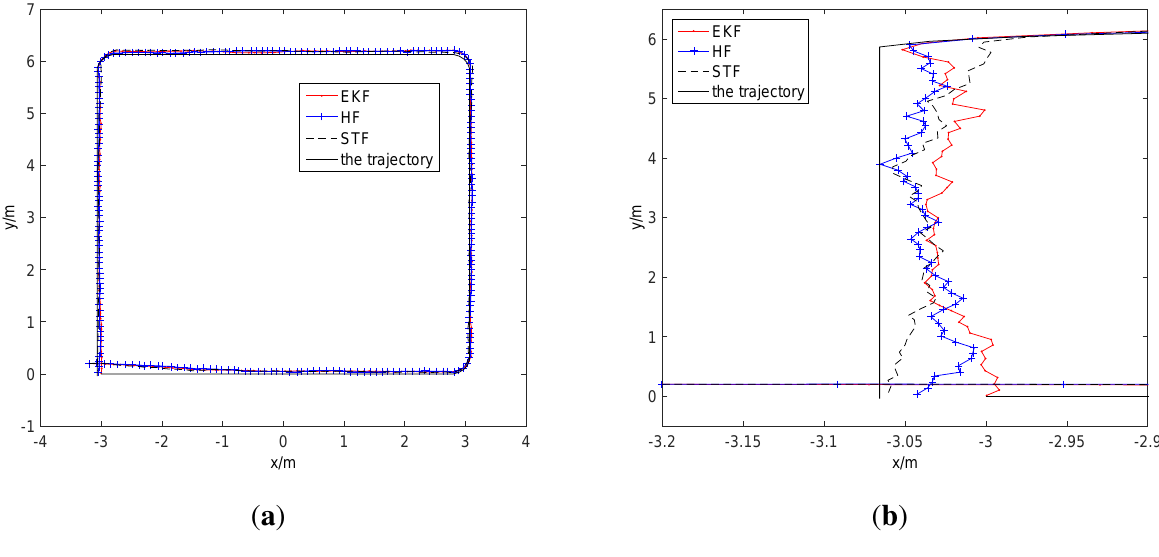
Figure 9. The tracking by filters. ( a ) The performance comparison; ( b ) the partial enlarged